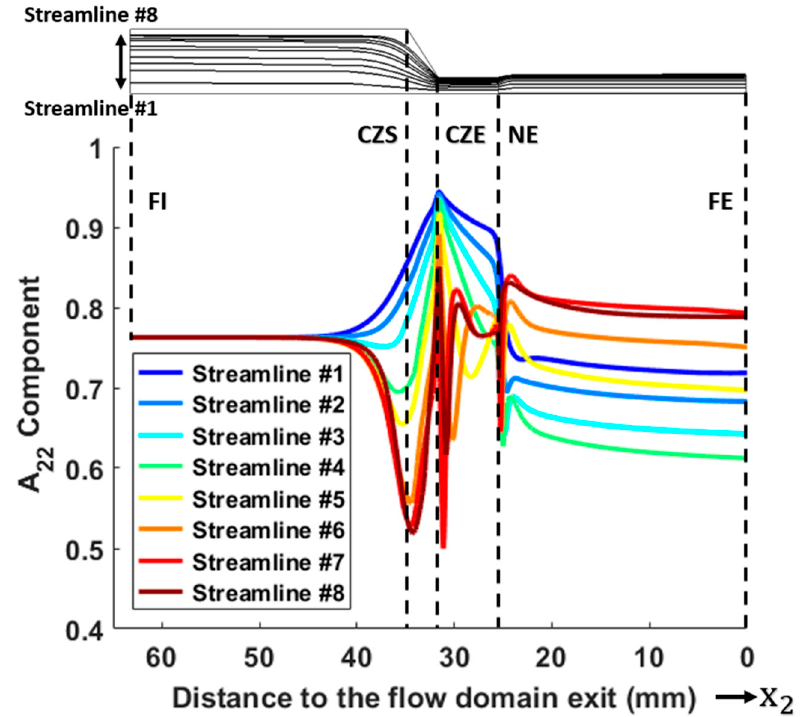
Figure 9. A 22 component of fiber orientation solution computed using the flow kinematics solved by the PTT model at Q equates 100 mm 3 /s.